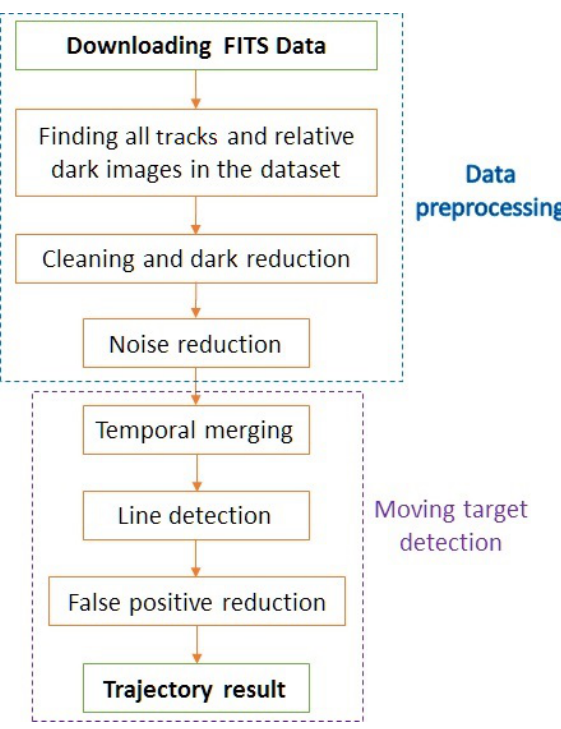
Figure 2. An overview of the proposed method Data preprocessing: Each track is a set of temporal images that are taken while the sensor is fixed in one location. There- fore, in each track, stars are stationary on the images. Our al- gorithm selects each track and detect the moving target in those sets of images. Figure 3 shows the clustering results to detect various tracks in a set of data.